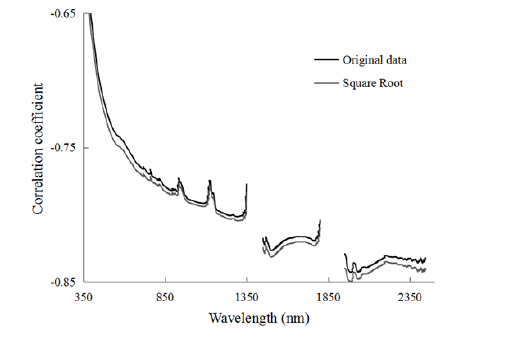
Figure 1.Correlation Coefficient between Water Content and Square Root Transformation of Reflectivity